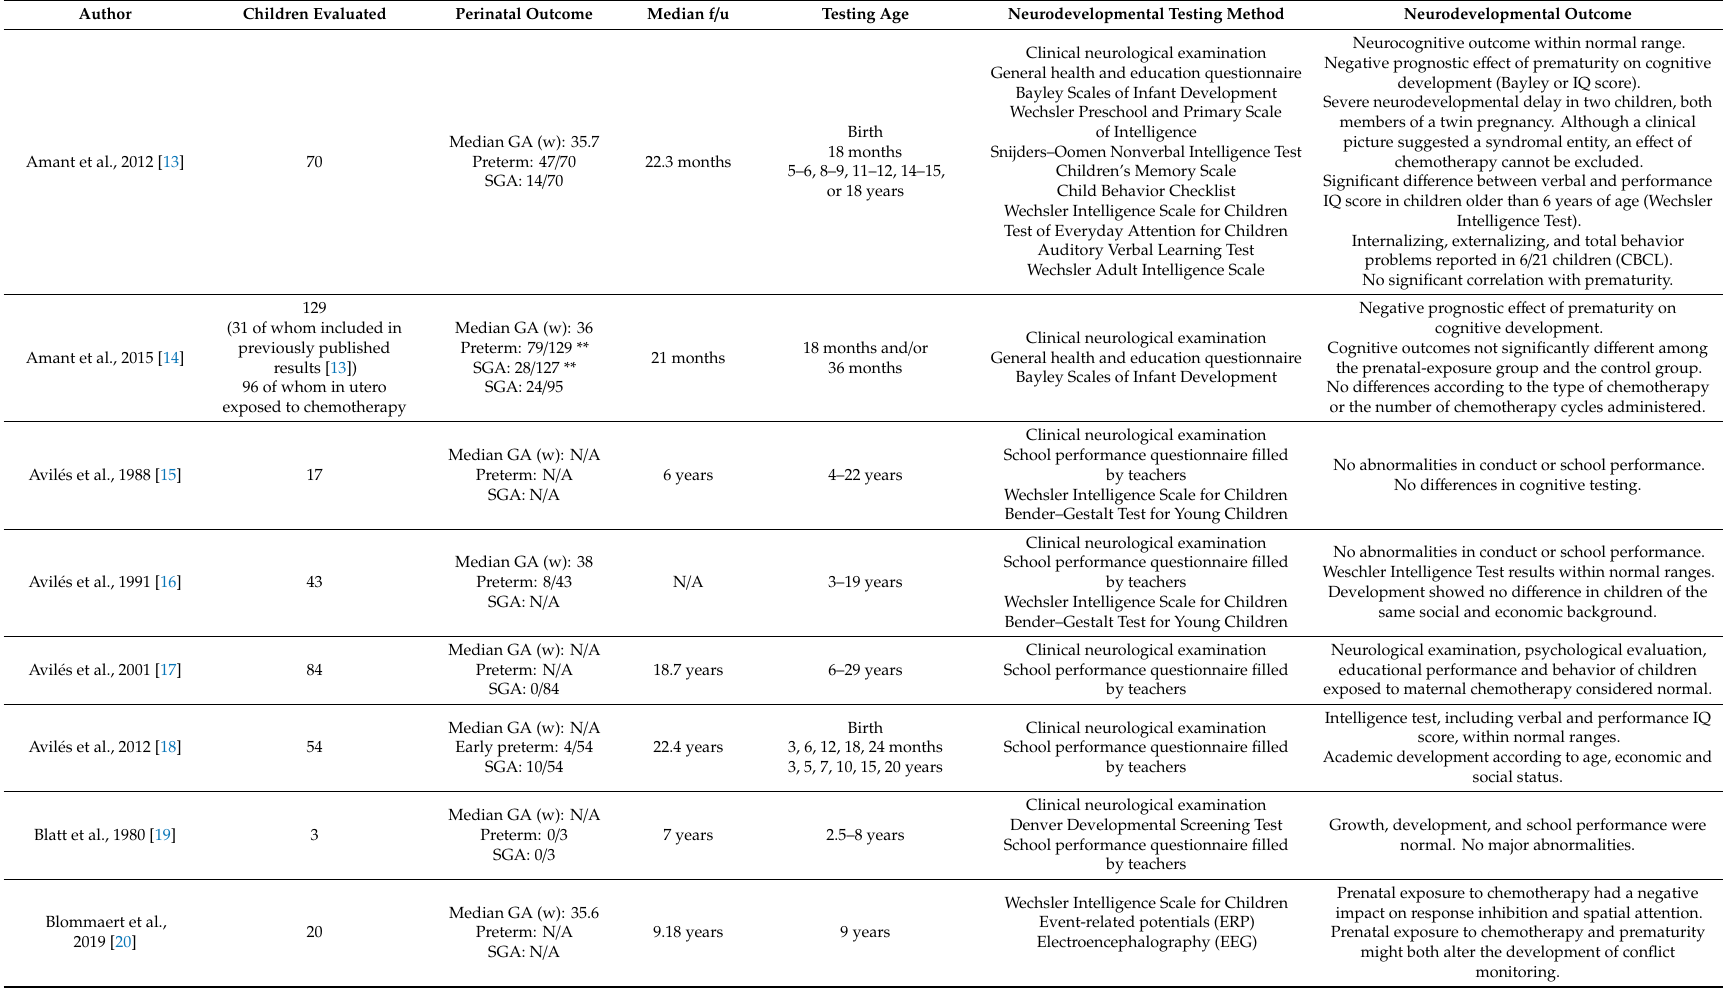
Table 2. Summary of the studies describing the neurodevelopmental outcome of children after in utero exposure to